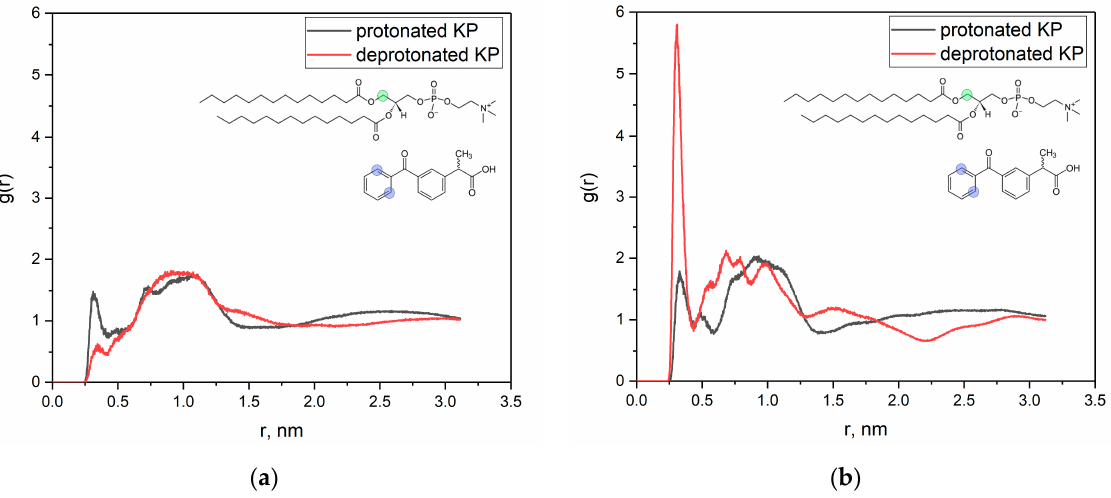
Figure 6. Radial distribution function g(r) of the hydrogens of KP (blue circles) and CH 2 -groups of DMPC (green circle) ( a ) in the absence of tryptophan; ( b ) in the presence of tryptophan.